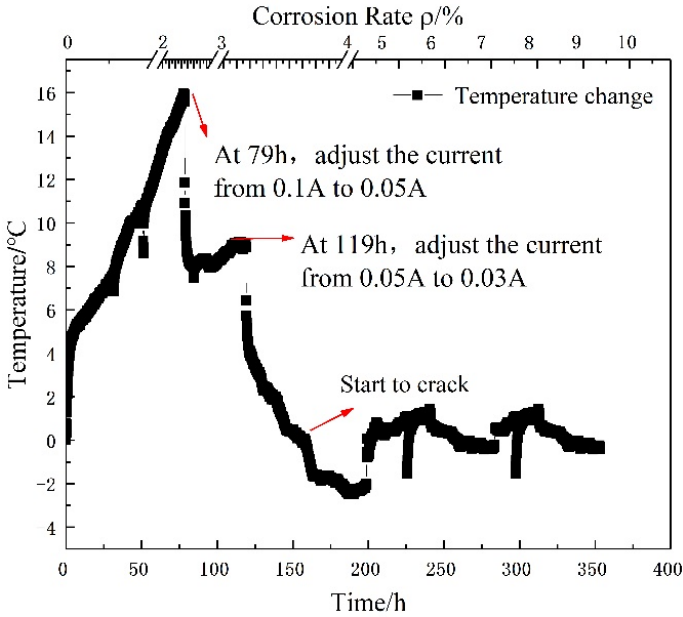
Figure 10. Temperature of rebar in electro-accelerated corrosion of 2-300# specimen. The strain-time curves before and after temperature compensation for specimens 2-150# and 2-300# are shown as Figures 11–13, and the test parameters for significance of fitting curve is list in Tables 2–7. The vertical axis represents the raw strain measured from the spiral distributed fiber sensor and actual strain subtracted the induced-strain by the temperature fluctuation. The top and below horizonal axes represent the mass loss rate and accumulated corrosion duration. The actual distributed strain of sensing fiber represents the corrosion-induced strain, whereas raw strain comprises that induced not only by corrosion expansion but also a varied temperature due to a corrosion